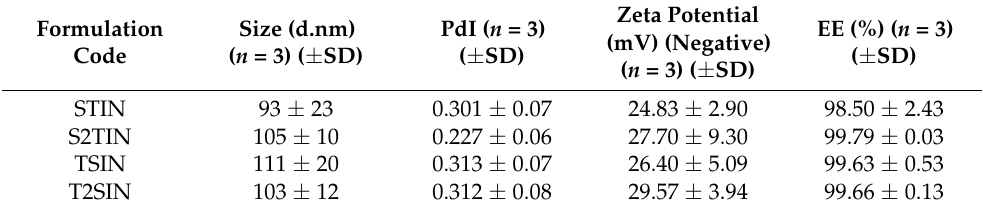
Table 2. Characterization (size, polydispersity index (PdI), zeta potential, and encapsulation efficiency (EE)) outcomes of the